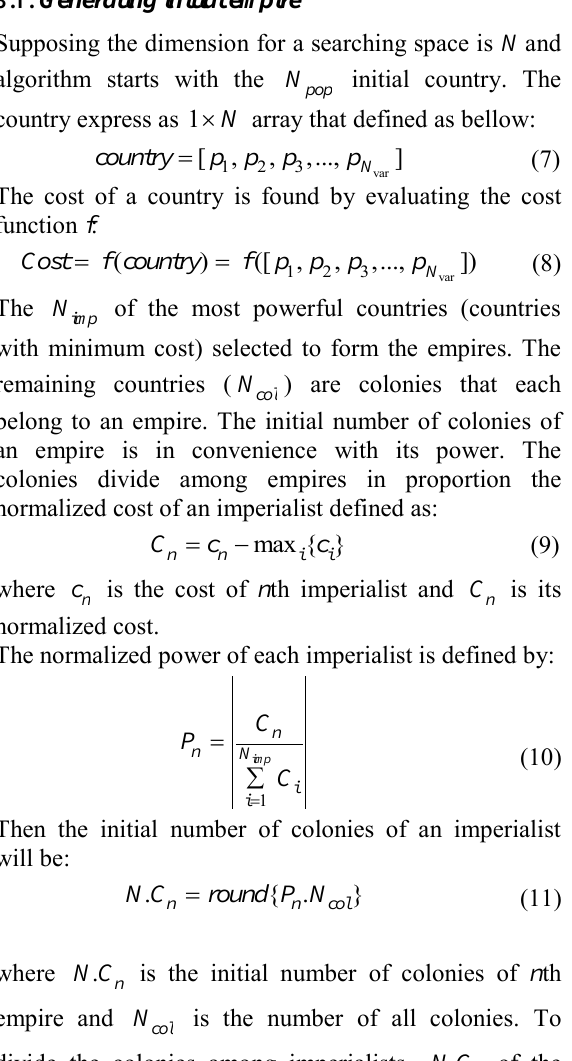
Fig. 2. Flowchart of the ICA